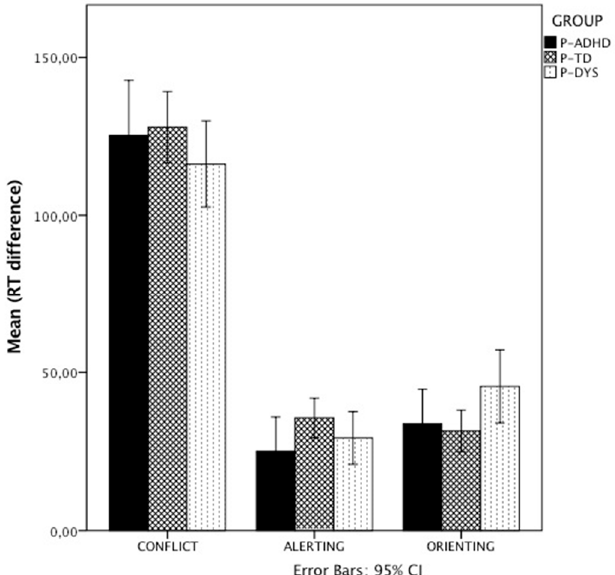
Figure 1. Magnitude (ms) of the three e ff ects of the ANT task broken by group of participants. Error bars represent 95% CI.